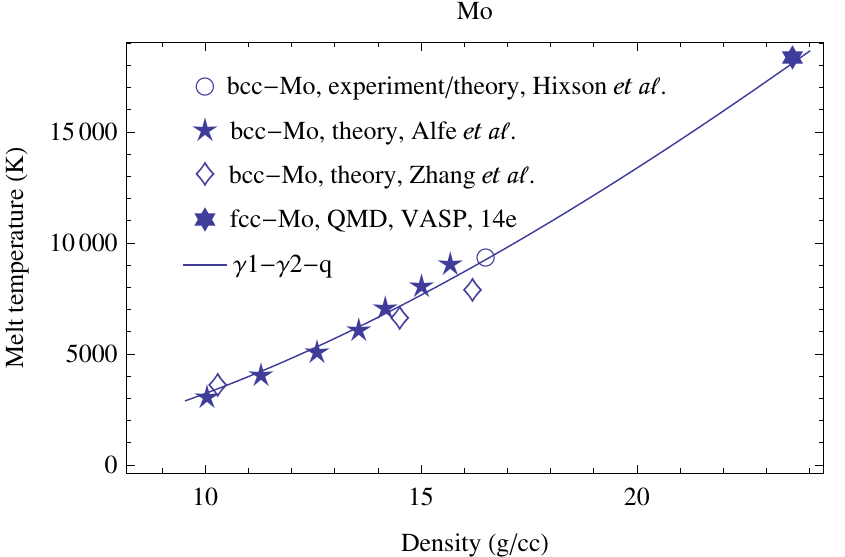
Figure 7. The melting curve of Mo: the unified analytic model ( γ 1 - γ 2 - q ) vs. the shock melting datapoint [7] and theoretical calculations including the most recent point from our own QMD